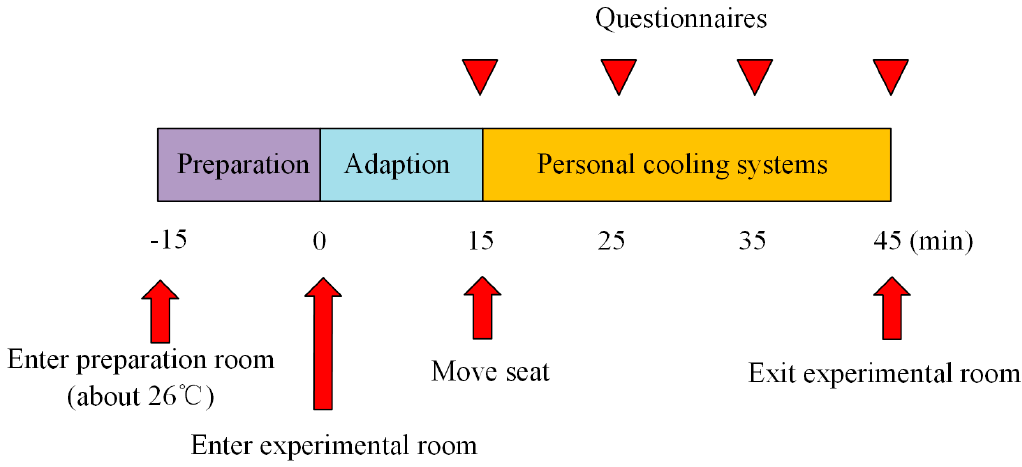
Figure 3. Experimental procedure.